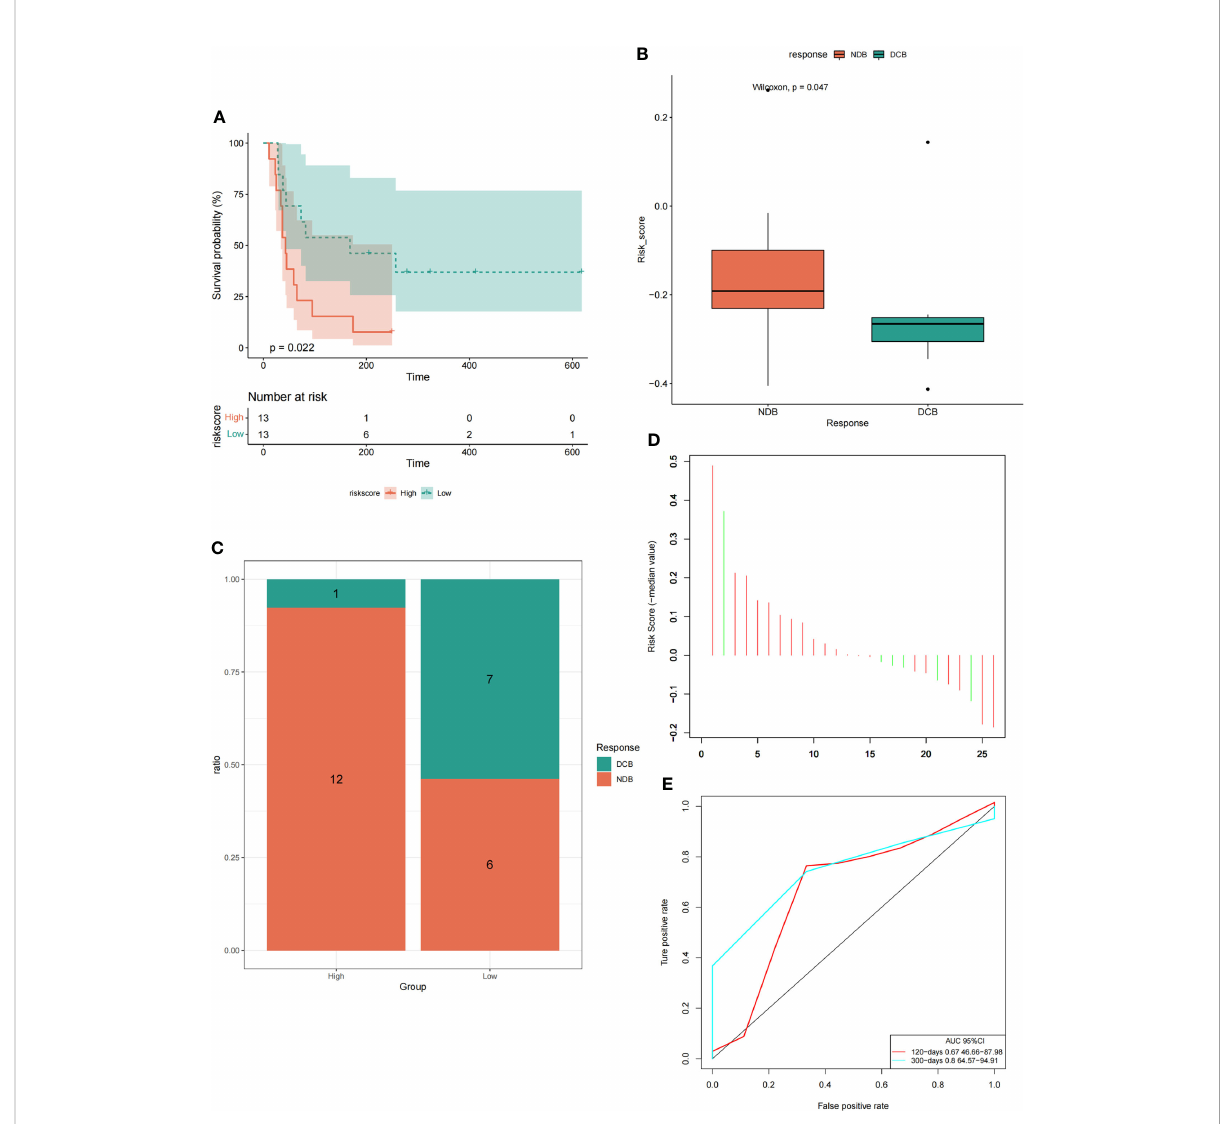
FIGURE 13 The model could predict the ef fi cacy of immunotherapy in LUAD patients. (A) Survival curve analysis under high and low-risk groups. (B) Analysis of intergroup differences in risk scores under two immunotherapy responses. (C) The proportion of two immunotherapy responses in the high-low risk group. (D) The risk score of the LUAD samples. (E) ROC veri fi cation curve of the